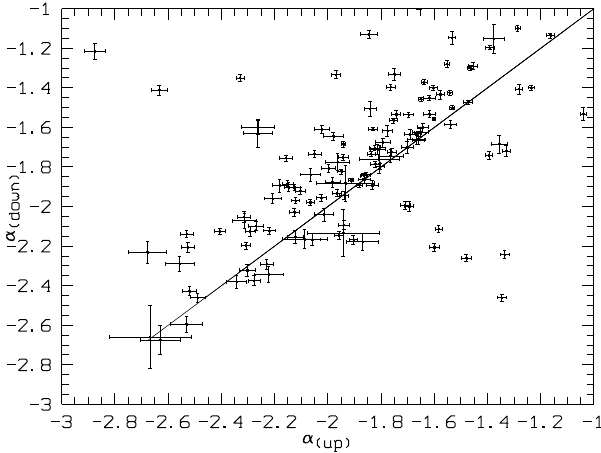
Figure 6. Plot of α down versus α up . The solid line indicates the straight line with α down = α up